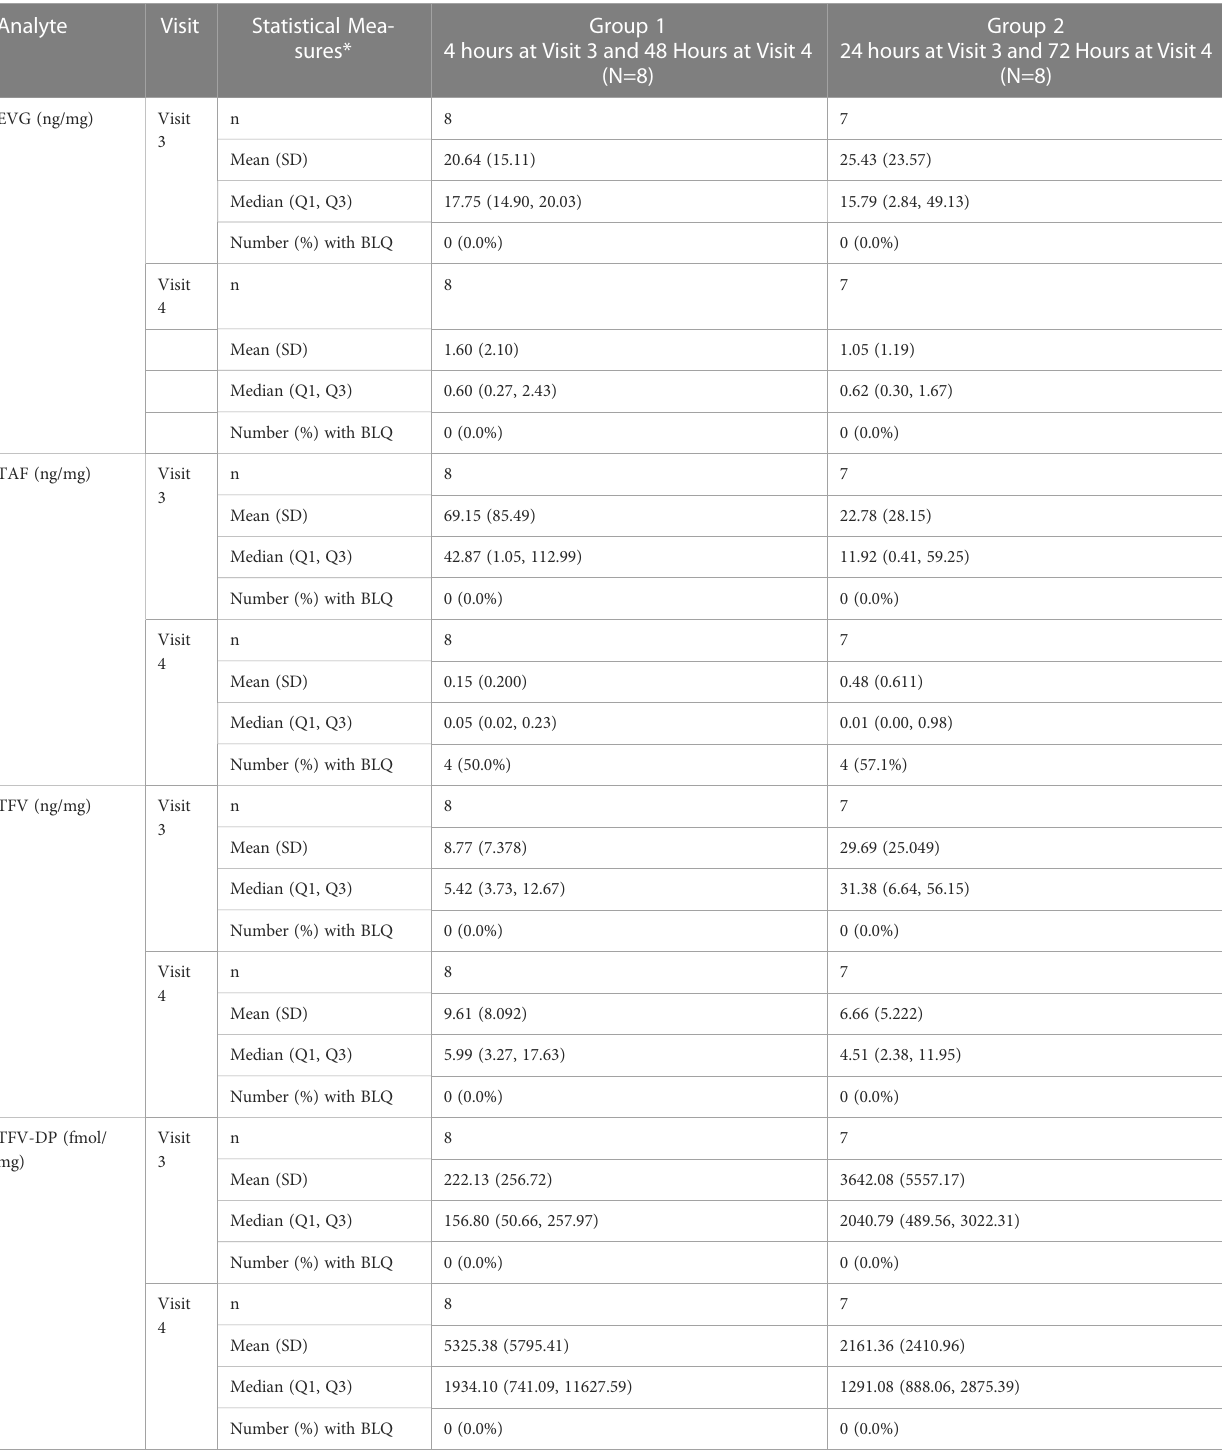
TABLE 4 Concentrations of EVG, TAF and TFV (ng/mg) and TFV-DP (fmol/mg) in vaginal tissue.